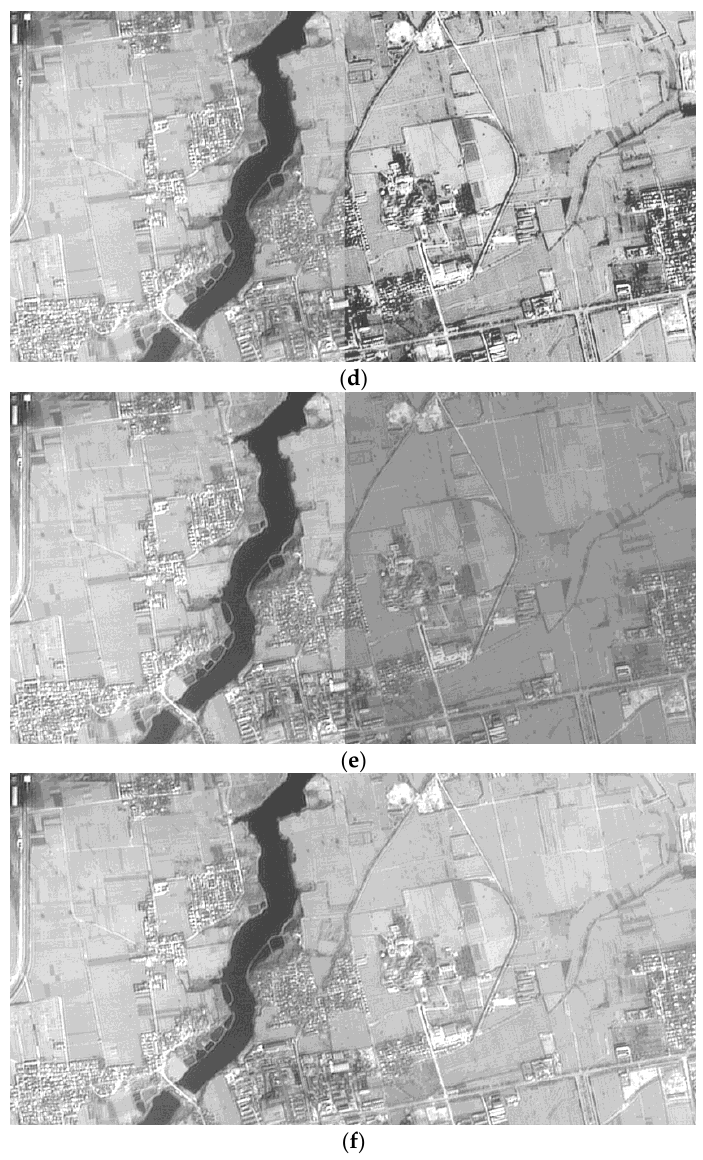
Figure 6. Comparison of different dodging algorithms: ( a ) original left image; ( b ) original right image; ( c ) image mosaicking of original images; ( d ) image mosaicking of two images after dodging based on histogram matching; ( e ) image mosaicking of two images after dodging based on information entropy; ( f ) image mosaicking of two images after dodging based on the Wallis filter.